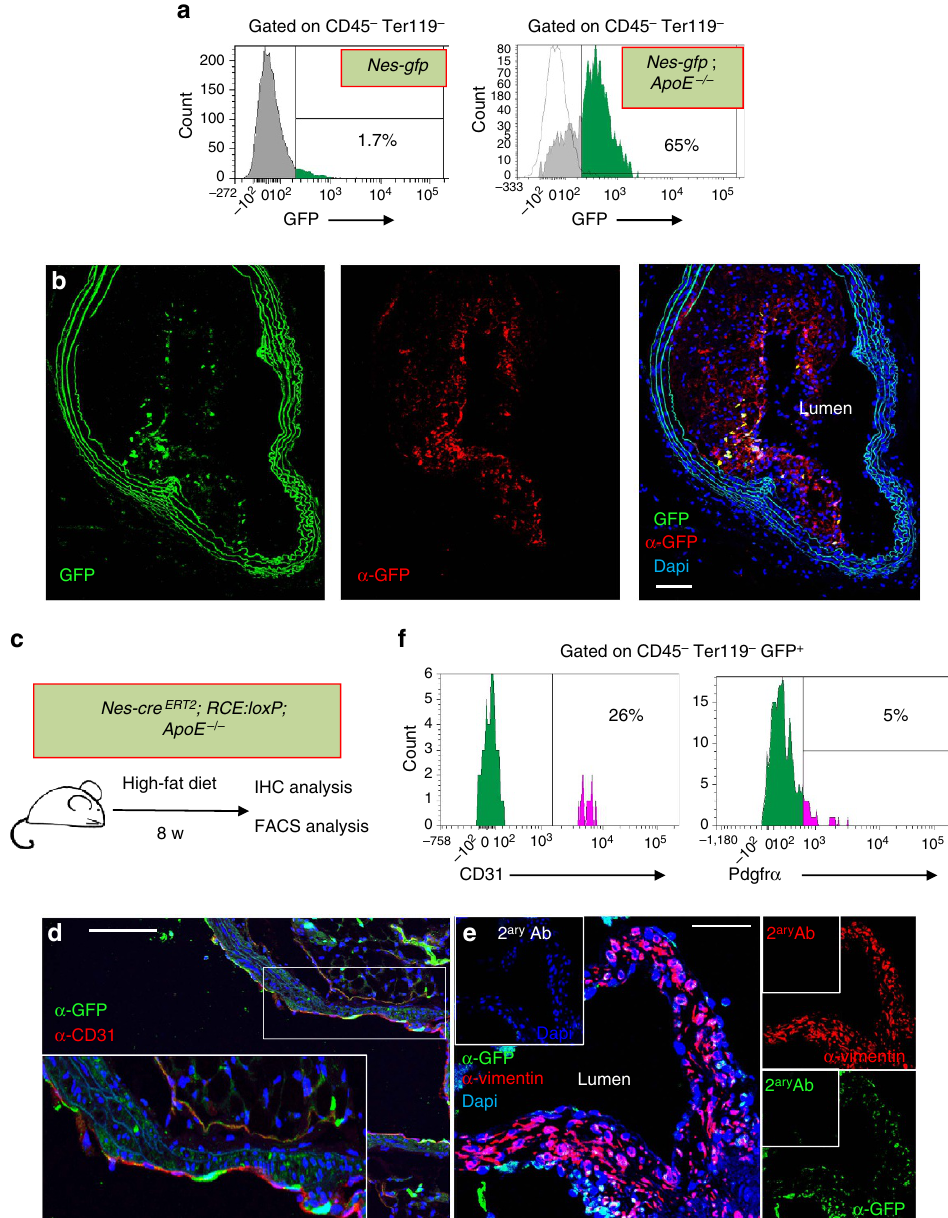
Figure 5 | Nestin þ cells participate in the formation of the atheroma plaque. ( a ) Flow cytometry of aortic stromal cells showing GFP expression in Nes-gfp mice fed with chow diet (left panel) and in Nes-gfp ; ApoE (cid:2) / (cid:2) mice fed with HFD for 2 months (right panel). ( b ) Representative GFP immunofluorescence of a section of the brachiocephalic artery branching out of the aortic arch of Nes-Gfp;ApoE (cid:2) / (cid:2) mice fed with HFD for 2 months. Abundant GFP þ cells were found in the atheroma plaque and the adventitial layer. GFP was detected with an anti-GFP antibody (red). Nuclei were counterstained with DAPI (blue). ( c ) Experimental design of lineage-tracing studies. Nes-cre ERT2 ;Rosa26-Gfp;ApoE (cid:2) / (cid:2) mice were injected with tamoxifen to trace the progeny of nestin þ cells and were fed with HFD for 2 months. ( d ) Immunofluorescence of the aortic valves using anti-GFP and anti-CD31 antibodies. Nuclei were counterstained with DAPI (blue). Inset, higher magnification of aortic leaflet. ( e ) Immunofluorescence of the aortic valves with anti- vimentin antibody. Nuclei were counterstained with DAPI (blue). ( f ) Flow cytometry histogram showing Pdgfr a and CD31 expression in aortic CD45 (cid:2) Ter119 (cid:2) GFP þ cells. The frequencies of depicted populations are indicated. ( b – e ) Scale bar, 100 m nestin þ cells—but not in endothelial cells only—increased circulating pro-inflammatory monocytes and neutrophils, but decreased their aortic infiltration (without affecting leukocyte adhesion to endothelium), delayed atheroma plaque formation and aortic valve calcification. Therefore, these results suggest that nestin expression marks stromal and endothelial cells that systemically regulate inflammatory cell migration in atherosclerosis.